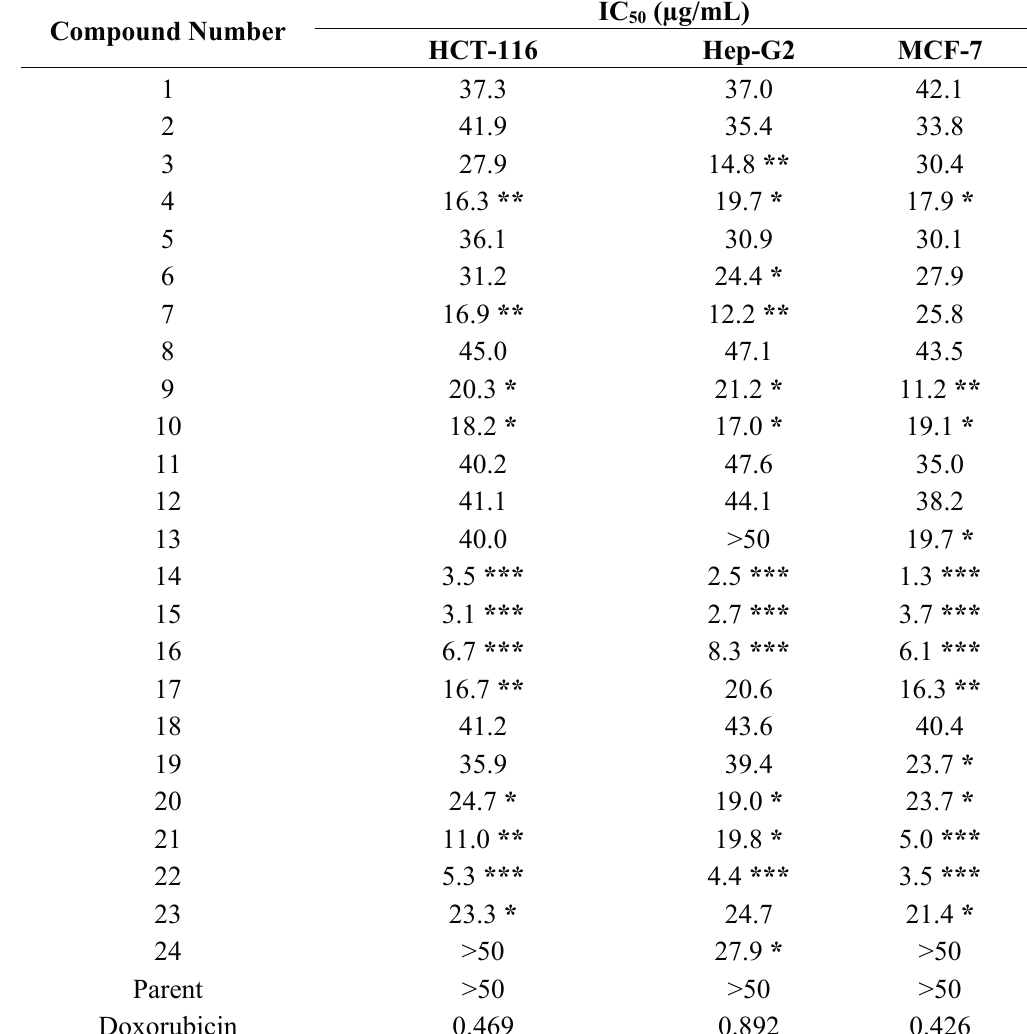
Table 2. Cytotoxicity of the target compounds 1 – 24 (IC 50 , μ g/mL). Compound